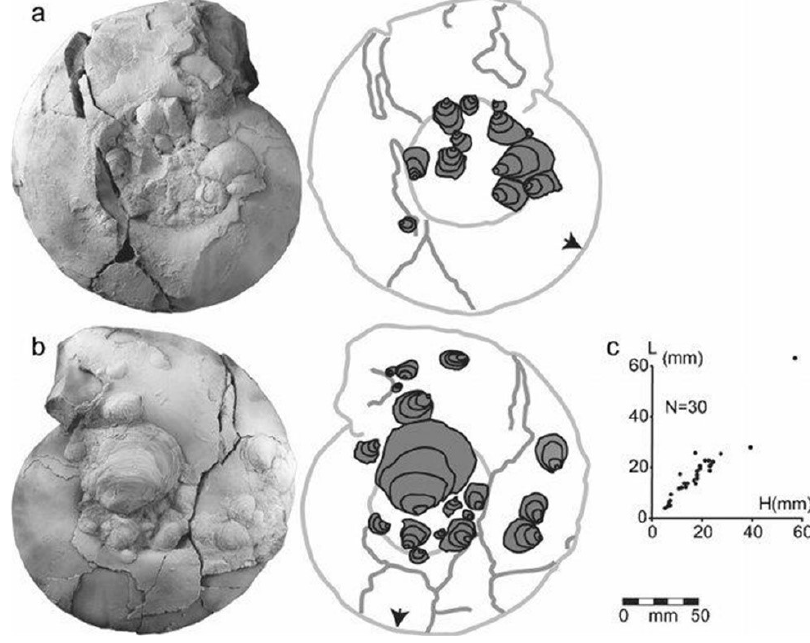
Figure 10. Analysis of oyster attachments positions on the ammonite shell [59].